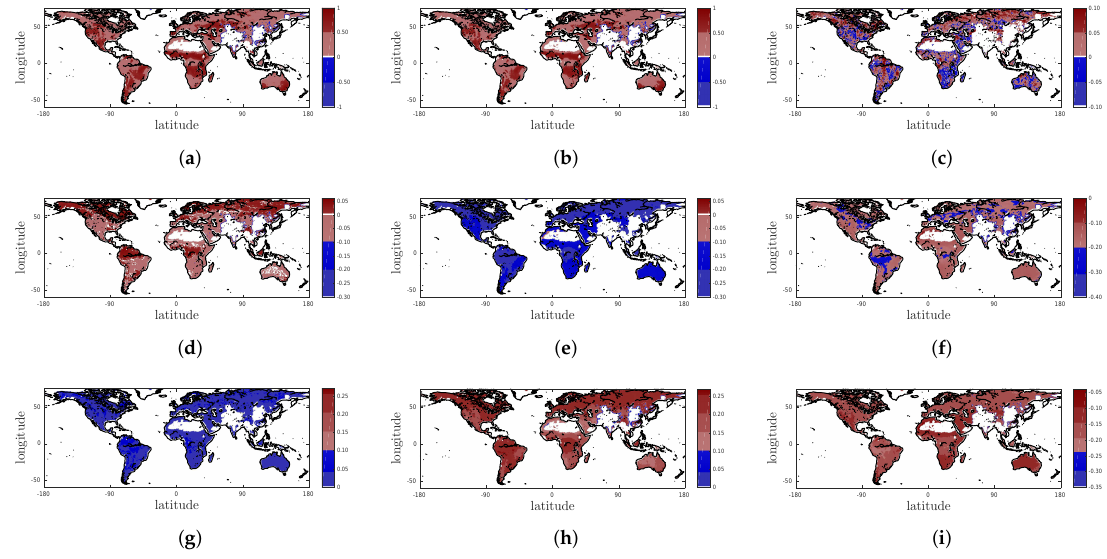
Figure 6. Spatial distribution of R (the top panels), BIAS (the middle panels), RMSE (the bottom panels) between the time series of DCNN/NN SM and ERA-Interim SM for SMOS ascending overpass in the testing phase. ( a ) R between DCNN SM and ERA-Interim SM; ( b ) R between NN SM and ERA-Interim SM; ( c ) difference in R (a minus b); ( d ) BIAS between DCNNM SM and ERA-Interim SM; ( e ) BIAS between NN SM and ERA-Interim SM; ( f ) difference in BIAS ( | d | minus | e | ); ( g ) RMSE between DCNN SM and ERA-Interim SM; ( h ) RMSE between NN SM and ERA-Interim SM; ( i ) difference in RMSE (g minus